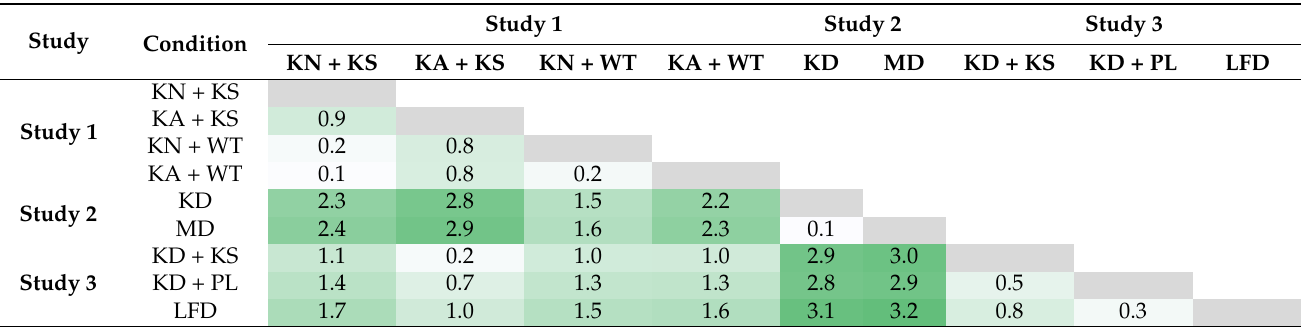
Table 3. BDNF Effect Size Matrix (Cohen’s d